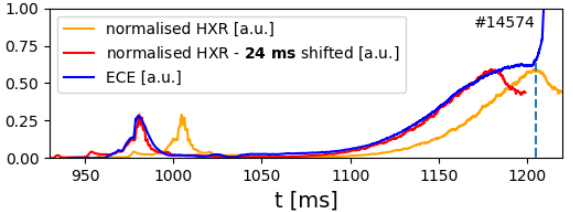
Figure 8. Smoothed HXR and V-ECE signal for the shot 14574.